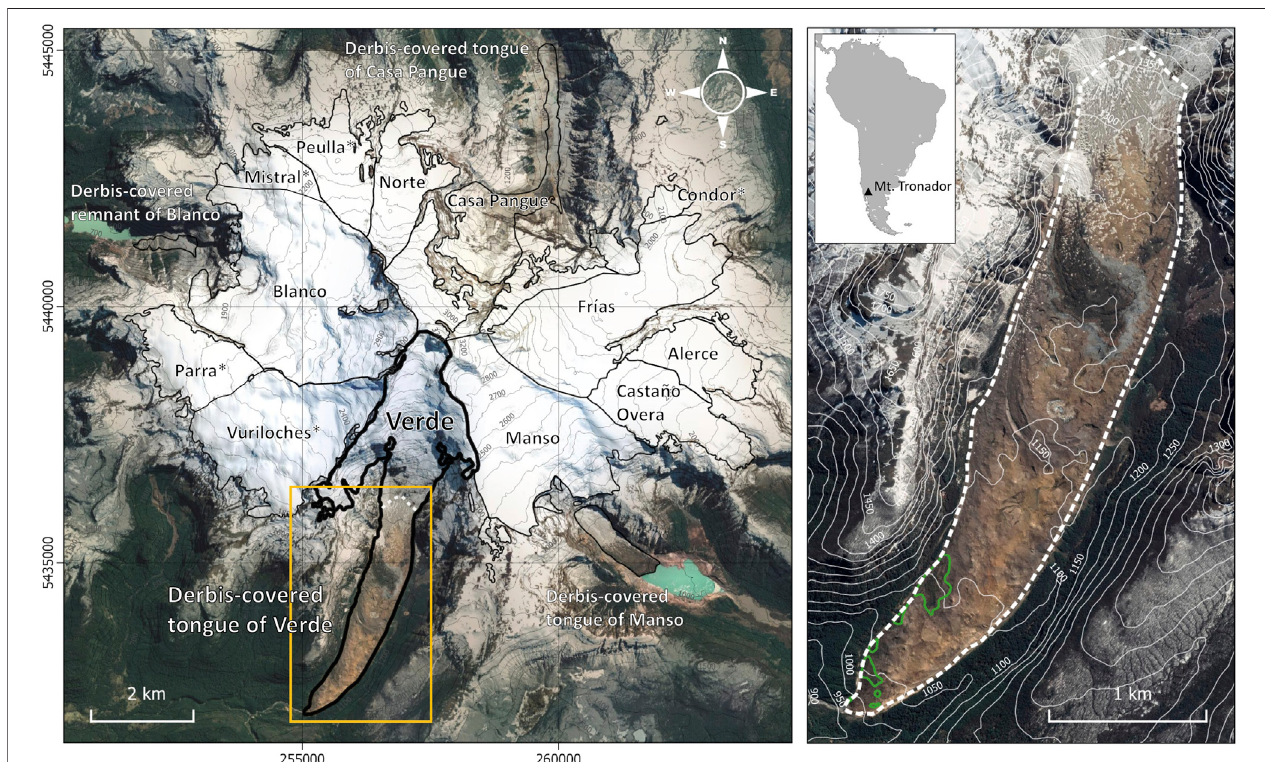
FIGURE 1 | Optical CNES/Airbus image of Monte Tronador from October 17, 2019. Verde glacier is delimited by the thick black line while other individual glaciers are delineated bythinblacklines.White dotted lineon Verdetongue markstheupper limit ofthedebriscover. Orangerectanglecorresponds totherightpanel, zooming in the debris-covered tongue of Verde glacier. The presence of some vegetation at the glacier lower part is indicated by green outline polygons. Coordinates in meters, universal transverse mercator (UTM) projection, zone 19, World Geodetic System (WGS84) datum.